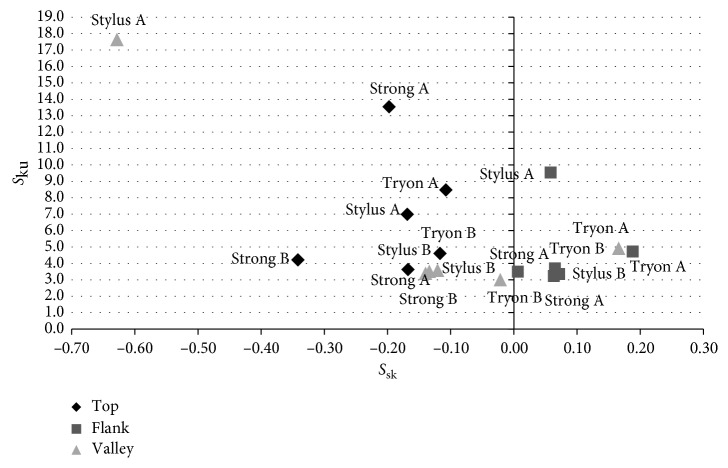
Morphological space of the parameters Ssk(x) × Sku(y) for implants B and A.